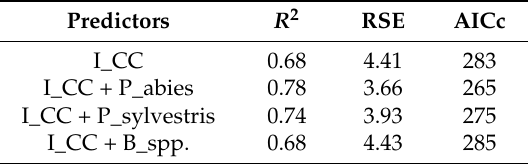
Table A2. Tested calibration models for the newest photographs in the Finnish landscapes. Used predictors were: I_CC = interpreted canopy cover for the cell; P_abies = interpreted proportion of P. abies in the cell; P_sylvestris = interpreted proportion of P. sylvestris in the cell; B_spp = interpreted proportion of birch species in the cell; and AICc = Akaike’s information criteria for small sample